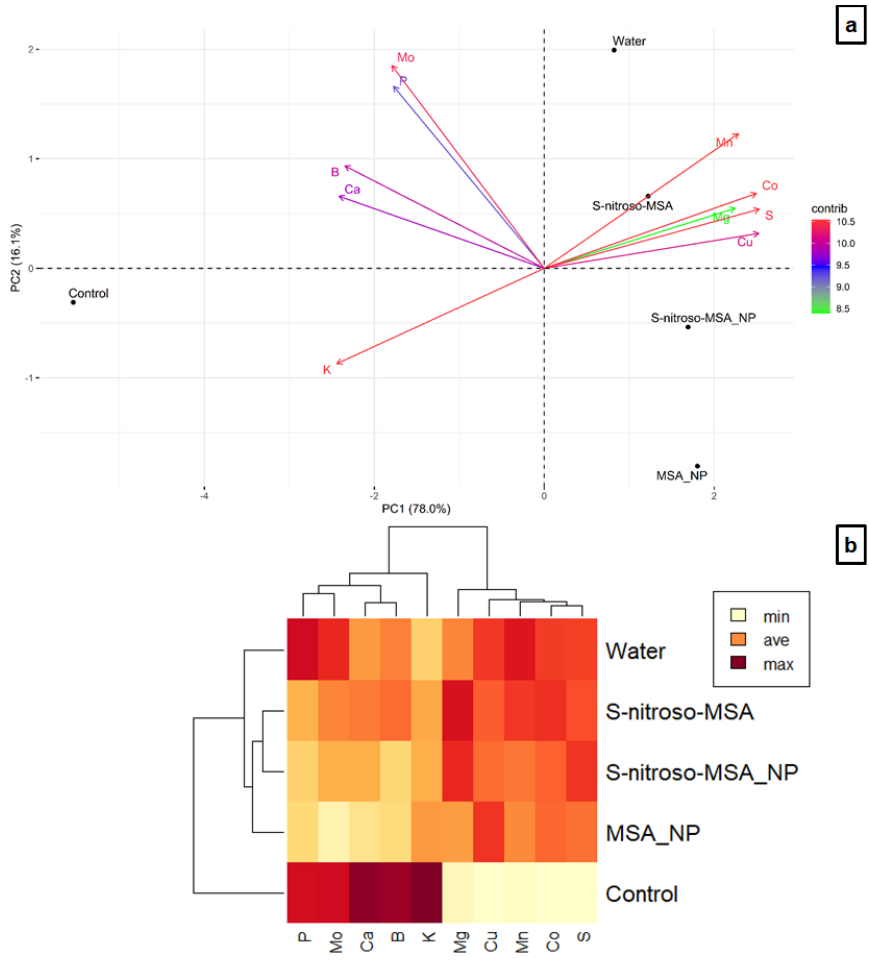
Figure 13. Principal component analysis ( a ), and heatmap hierarchical clustering analysis ( b ) of the essential nutrients in the roots of soybean plants cultivated in soil containing different copper (Cu) levels (natural content: 11 mg kg − 1 ; severe Cu stress: 244 mg kg − 1 ). Control = treatment with distilled water and soil with natural copper content; water = treatment with distilled water after Cu addition; S-nitroso-MSA_NP = treatment with a nanoencapsulated NO donor (S-nitroso-mercaptosuccinic acid) at 1 mM and soil with copper supplementation; S-nitroso-MSA = treatment with a NO donor (S-nitroso-mercaptosuccinic acid) in the free form at 1 mM and soil with copper supplementation; MSA_NP = treatment with nanoparticles containing the non-nitrosated MSA at 1 mM and soil with copper supplementation. Data are the average of the four replicates per treatment.